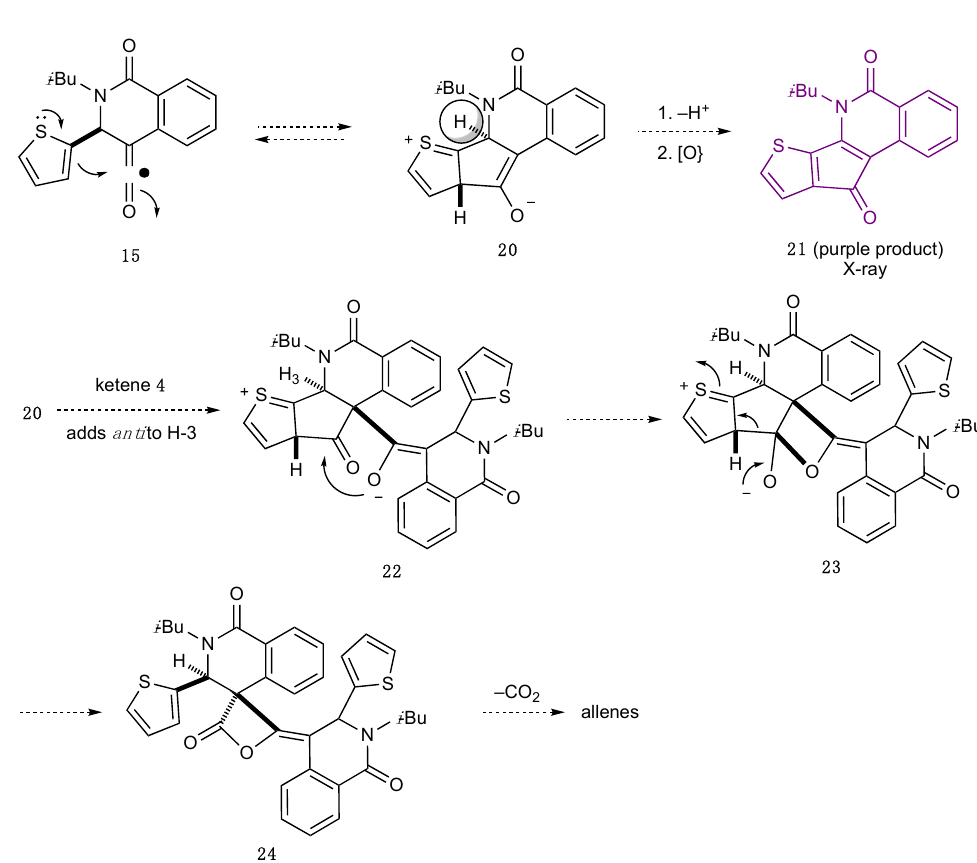
Scheme 3. Possible pathway for formation of the purple product, and dimerization pathway